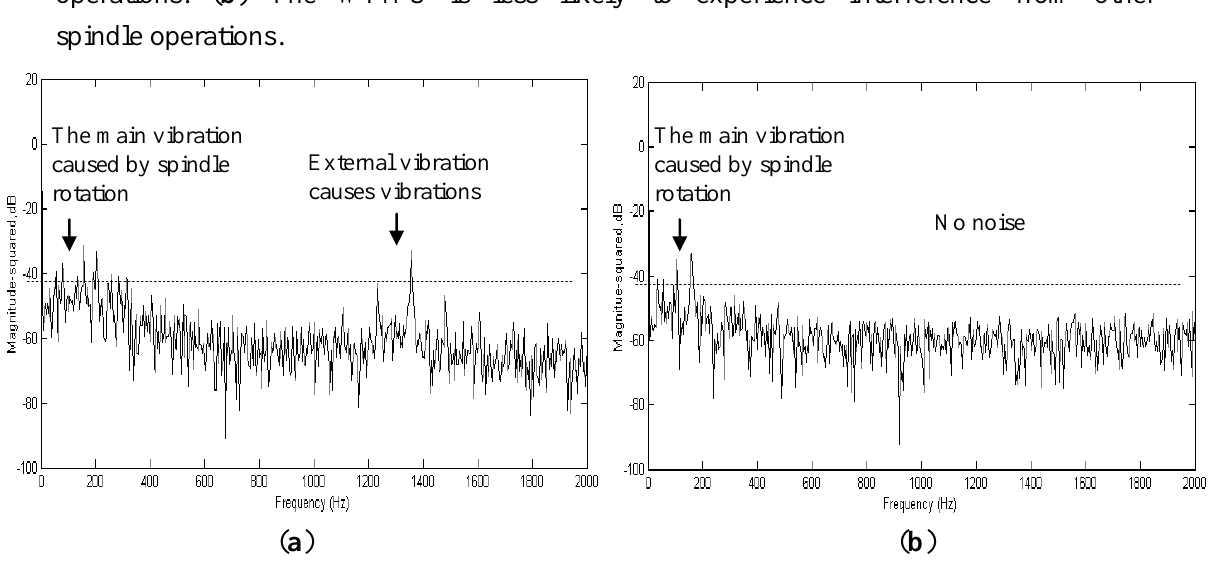
operations. ( b ) The WPMS is less likely to experience interference from